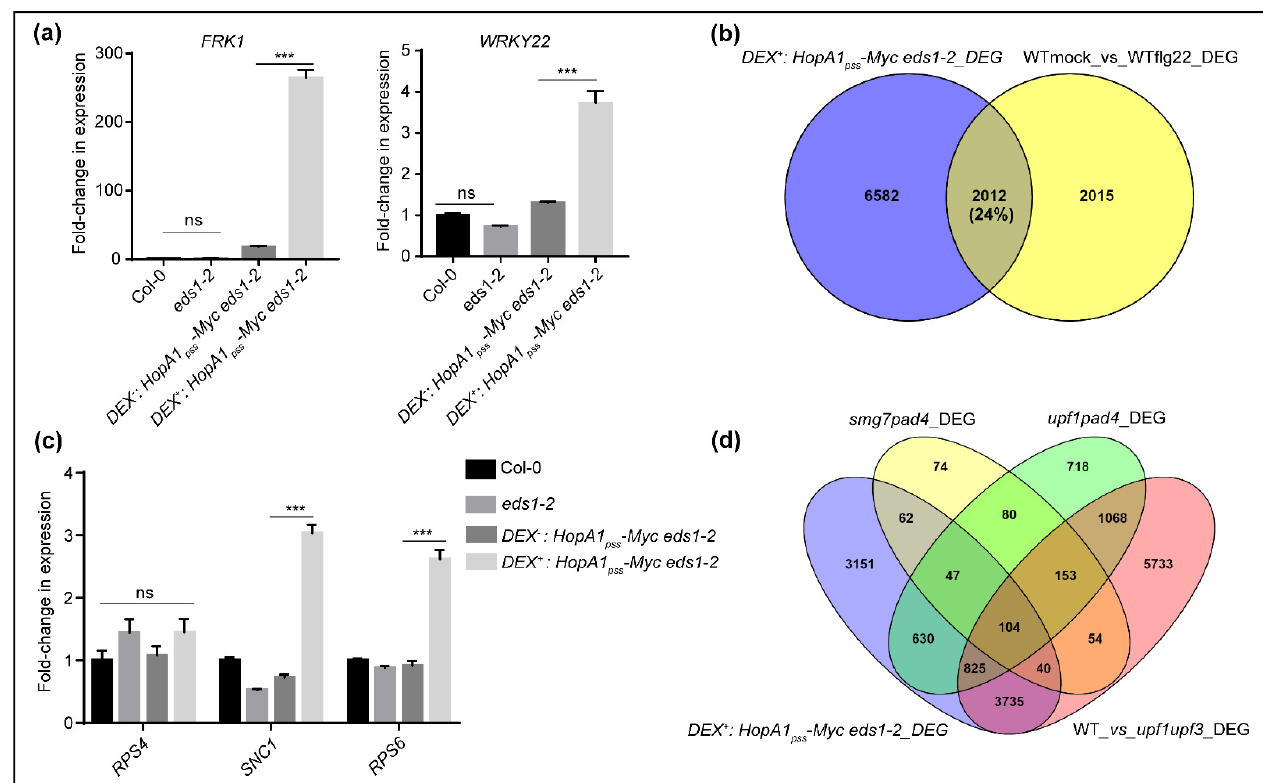
Figure 3. ETI HopA1pss -like elicitation upregulates expression of PTI and other defense-associated transcripts. ( a ) Expression levels of PTI markers ( FRK1 , WRKY22 ), and ( c ) R genes RPS4 , SNC1 and RPS6 in HopA1 pss -expressing transgenic at 12 hpin or uninduced control, Col-0 and eds1-2 plants. Venn diagram of DEG overlaps of Dex + HopA1 pss plants with similar datasets from ( b ) flg22-treated versus untreated WT (Col-0) (from Bazin et al., 2020), ( d ) smg7 pad4 , upf1 pad4 or upf1 upf3 versus Col-0 (from Raxwal et al., 2020), Data shown is mean ± SD ( n = 3) and presented as fold-change relative to Col-0. Statistical significance is with Student’s t -test and show pairwise comparisons to Col-0 levels ( * ** p < 0.001).